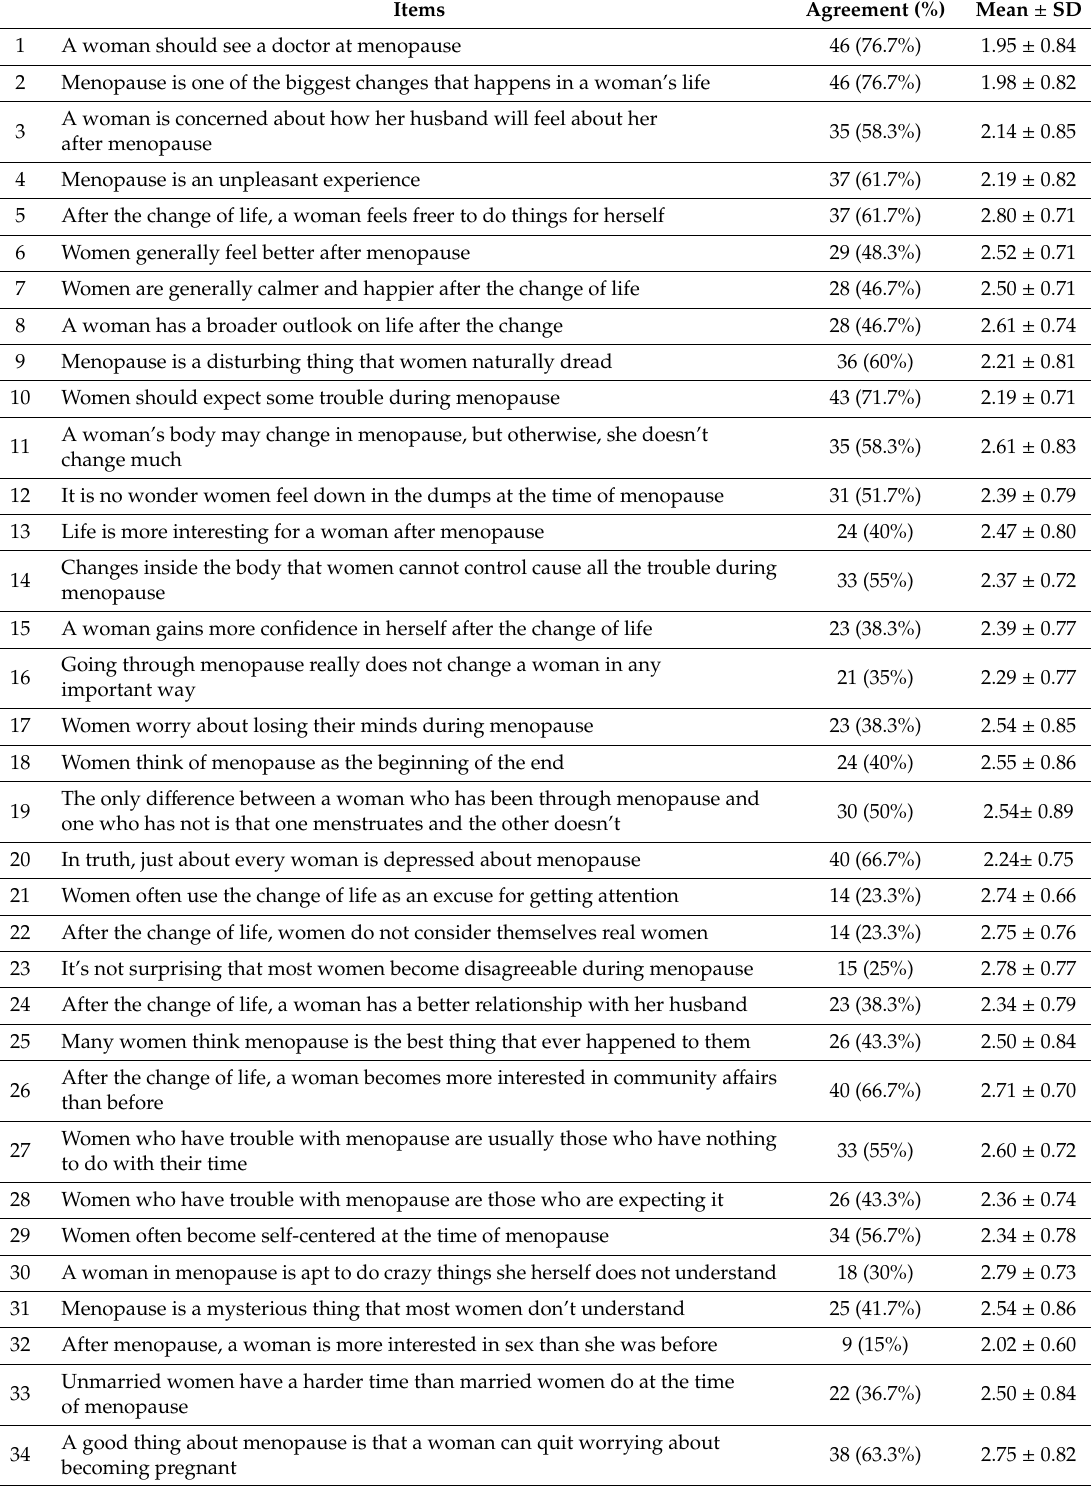
Table 4. The percentage of participants who agreed and strongly agreed to items of the attitudes toward menopause scale, along with mean ± SD for each item. Items Agreement (%) Mean ±